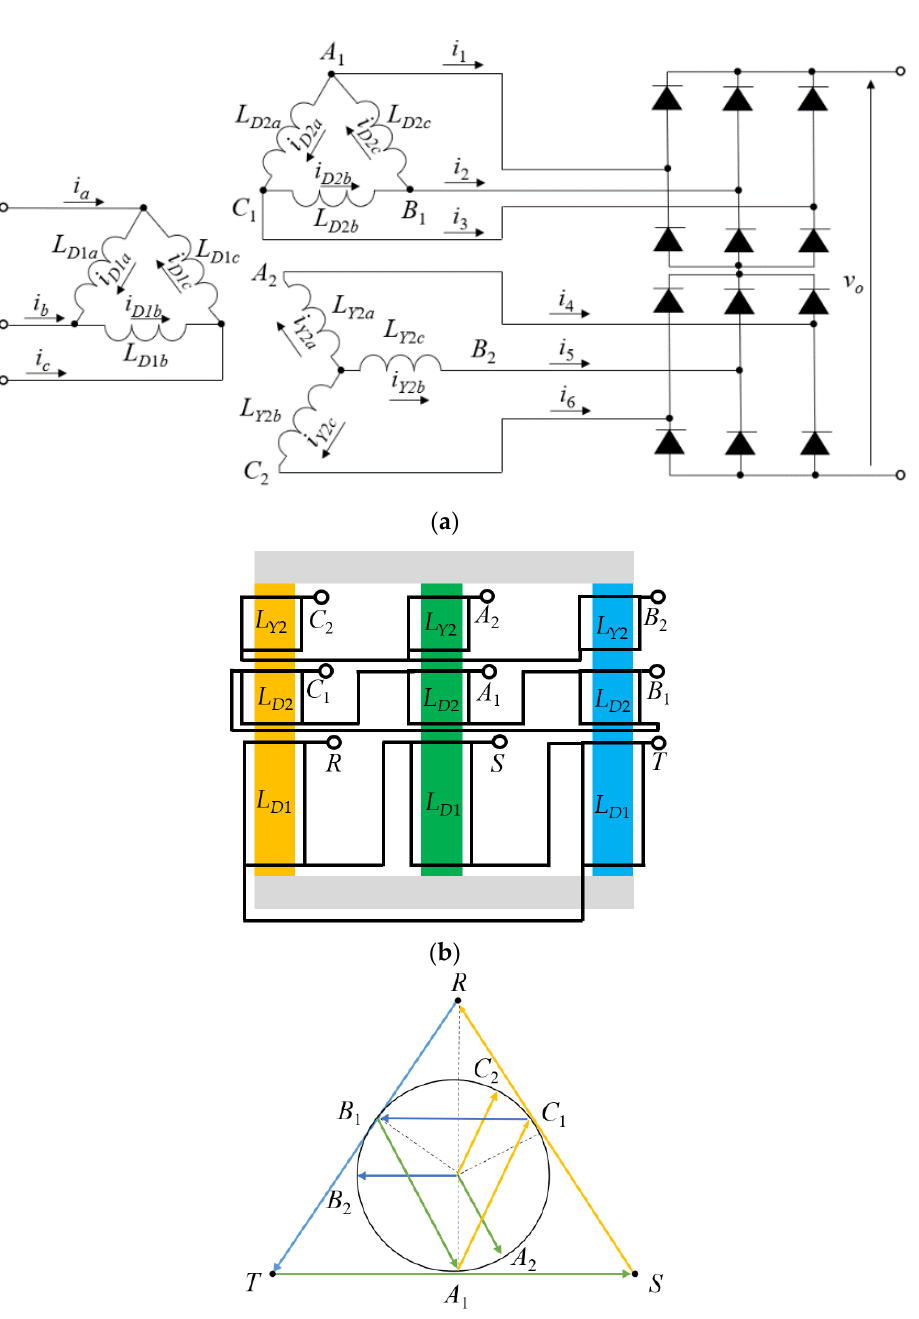
Figure 1. Schematic of CTU 12-pulse rectifier. ( a ) Electrical circuit. ( b ) Magnetic structure representation. ( c ) Phasor diagram representation.